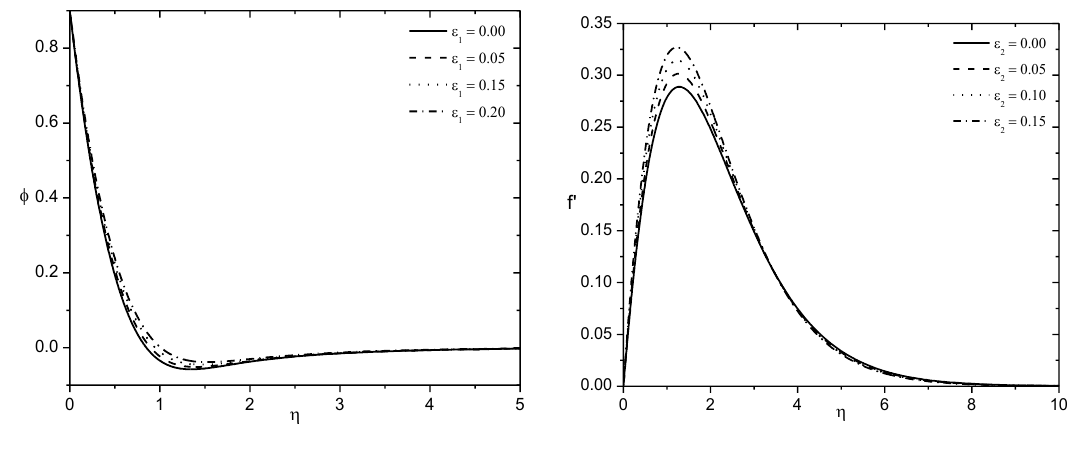
 on the Velocity 2